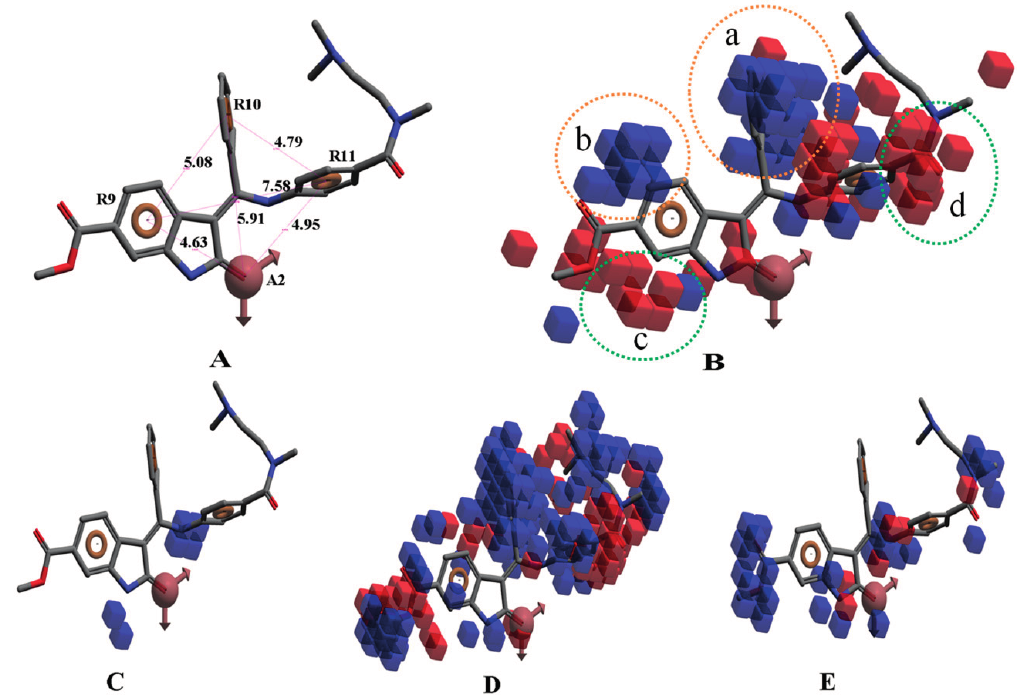
Figure 3. ( A ) The hypothesis (ARRR) that yielded the 3D-QSAR model of group 1; ( B ) Visualization of the 3D-QSAR model of group 1; Decomposed effects from ( C ) H-bond donor; ( D ) Hydrophobic/non-polar and ( E ) Electron-withdrawing of reference ligand (BindingDB50279269). The interaction is represented by clouded cubes where the blue ones indicate a favorable effect and the red ones indicate unfavorable effects. The colored circles indicate favorable and unfavorable interaction domains of the 3D-QSAR